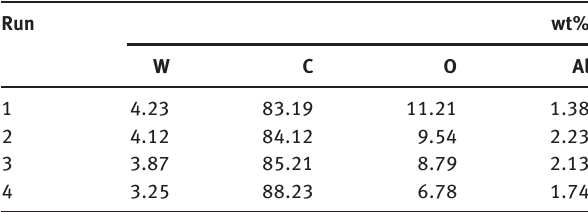
Table 6: Element compositions of reused catalyst of